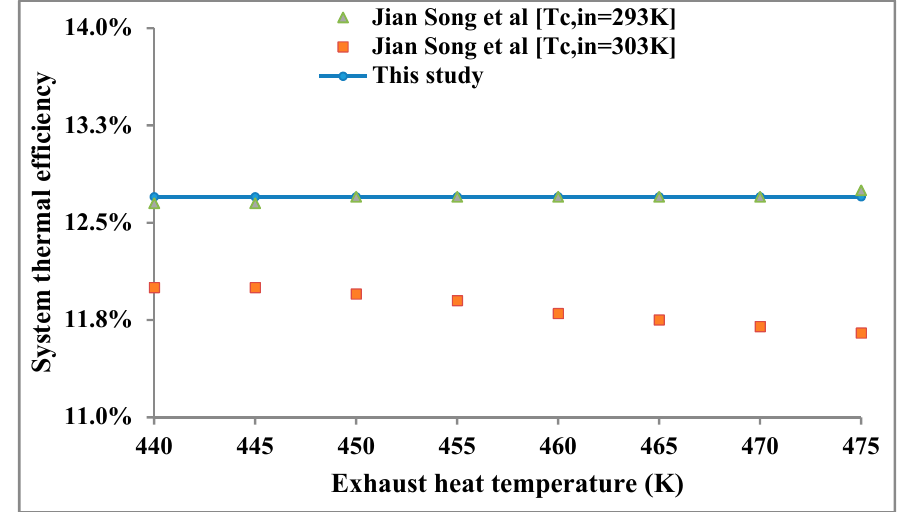
Figure 5. System thermal efficiency vs. exhaust heat temperature.